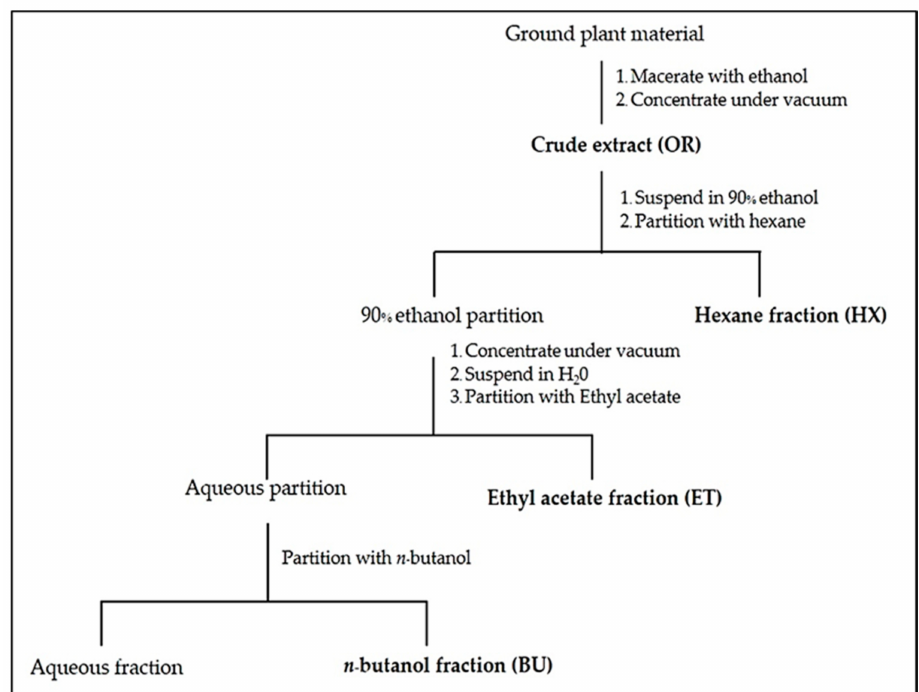
Figure 8. The prepared extracts representing a range of polarities. The OR, HX, ET, and BU crude extracts were redissolved in the original extraction solvent to compare their phytotoxic effects. An aliquot (5 mL) of each solution at different concentrations (500, 1000, 2000, and 4000 ppm) was added to 9-cm Petri dishes lined with two germination papers and evaporated to dryness in a fume hood. After evaporation, distilled water (5 mL) was added to the germination paper, and 20 seeds of either A. viridis or E. crus-galli were evenly placed on the paper. Distilled water was used as the control. The experimental design, incubation conditions, and data collection were the same as in the bioassay described